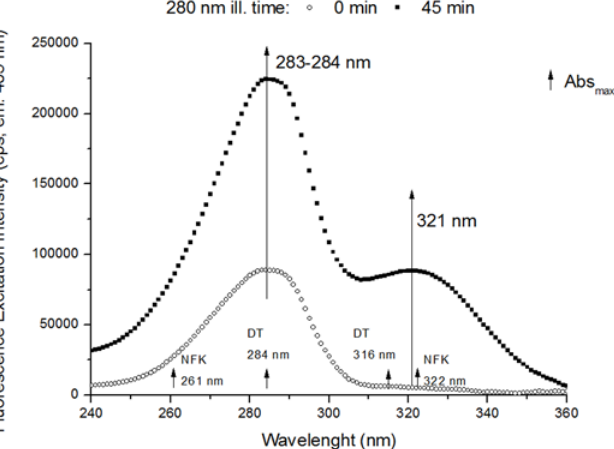
Fig 9. Fluorescence excitation spectra of human plasminogen (405 nm emission). Fluorescence excitation spectra (emission at 405 nm) obtained before and after 280 nm continuous illumination (45 min) of human plasminogen in solution. There is an increase in excitation intensity at the peak located at ~283 – 284 nm and a new peak is formed at 321 nm upon 280 nm illumination. Small increasing arrows indicate the wavelengths of maximum absorption (Abs max ) of DT, Kyn and NFK in solution.